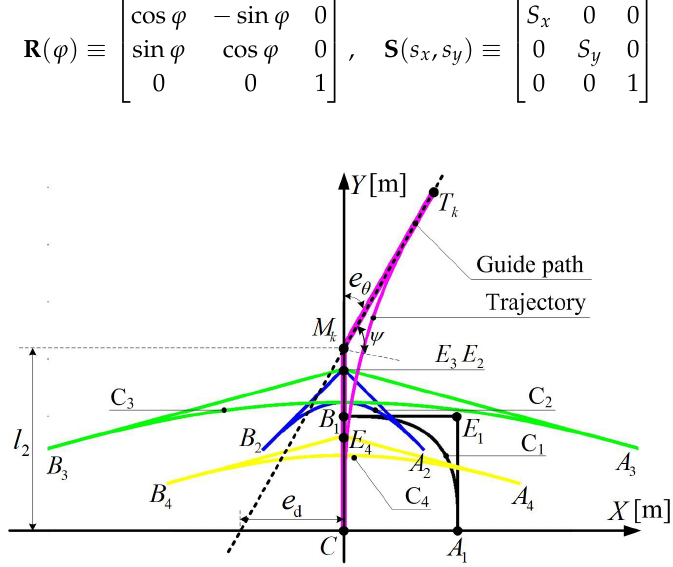
Figure 7. Affine transformations of Lamé curves for